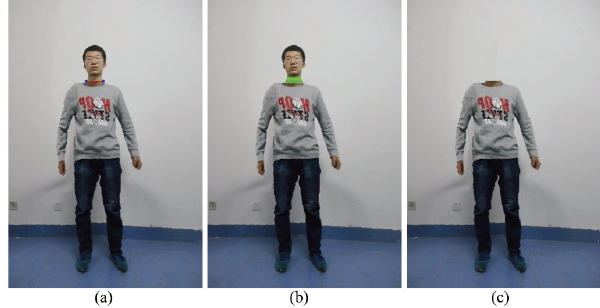
Head swapping. (a) Blue: control points on neck, red: stitching line. (b) Green: Poisson fusion area. (c) Result after removing the original head from the reshaped